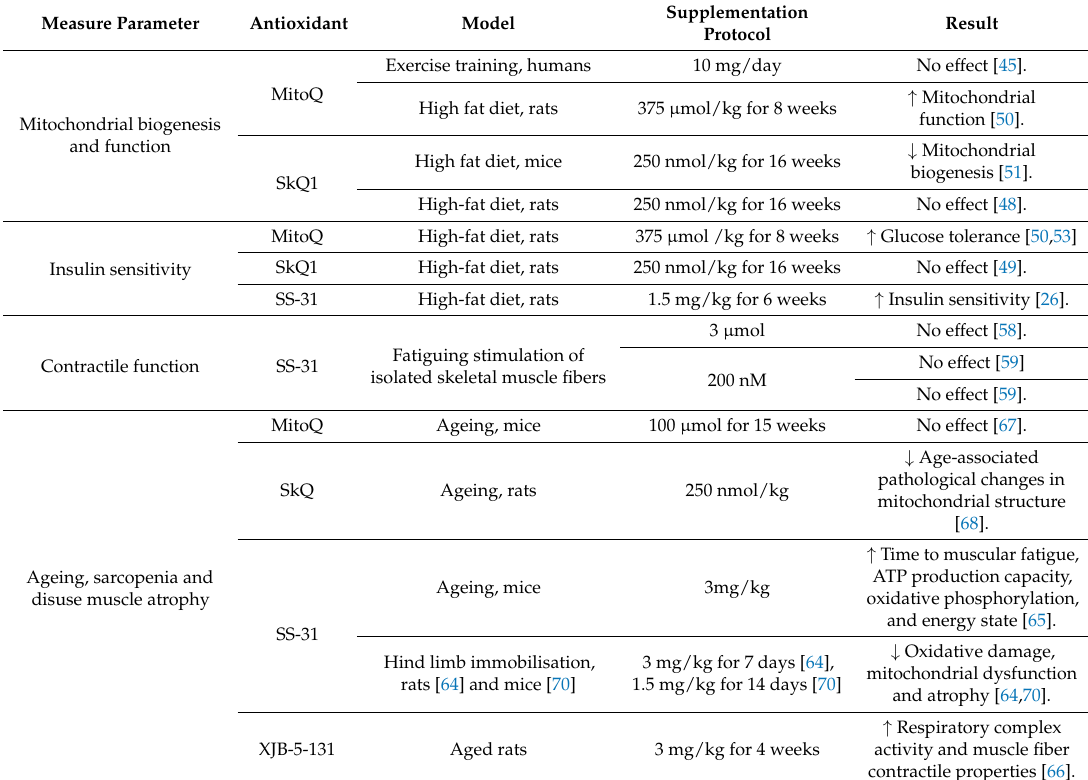
Table 1. The effect of mitochondria-targeted antioxidants on different parameters of muscle